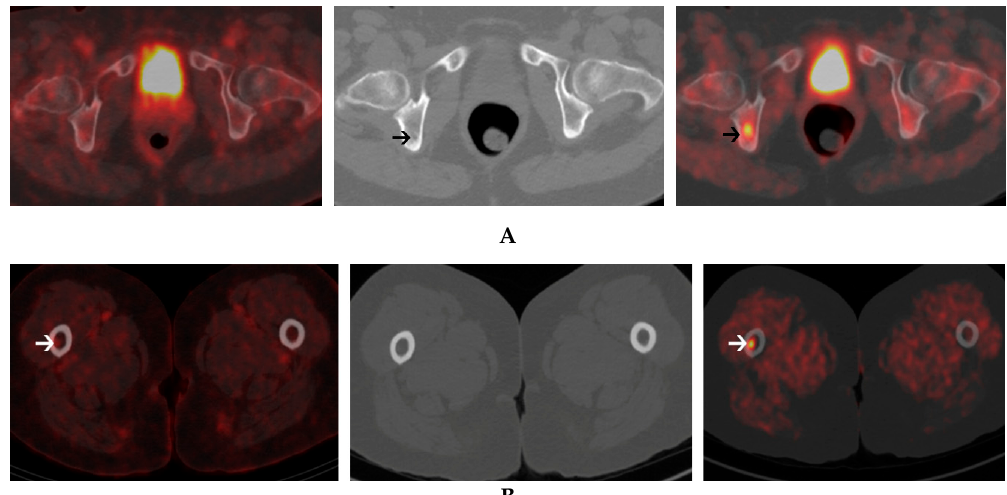
Figure 4. A 56-year-old female with IgG kappa MM. 18 FDG PET/CT (left panel) and 18 F-Choline PET/CT (right panel) were performed with a 3-day-interval. An axial PET/CT image of the pelvis shows a focal uptake of 18 F-Choline within the right ischium without a corresponding uptake on 18 FDG PET/CT. The corresponding axial CT image (central panel) shows no clear-cut structural changes ( A ). A focal lesion of the right femur exhibits a high uptake of 18 F-Choline. This lesion exhibits only a faint uptake on 18 FDG PET/CT (left panel) and is not visible on CT (central panel) ( B ).